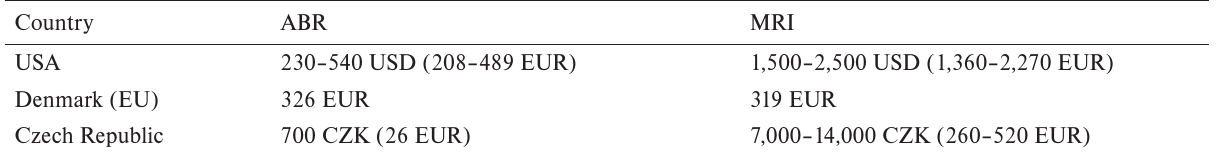
Table 1. A comparative pricing table for ABR and MRI in some